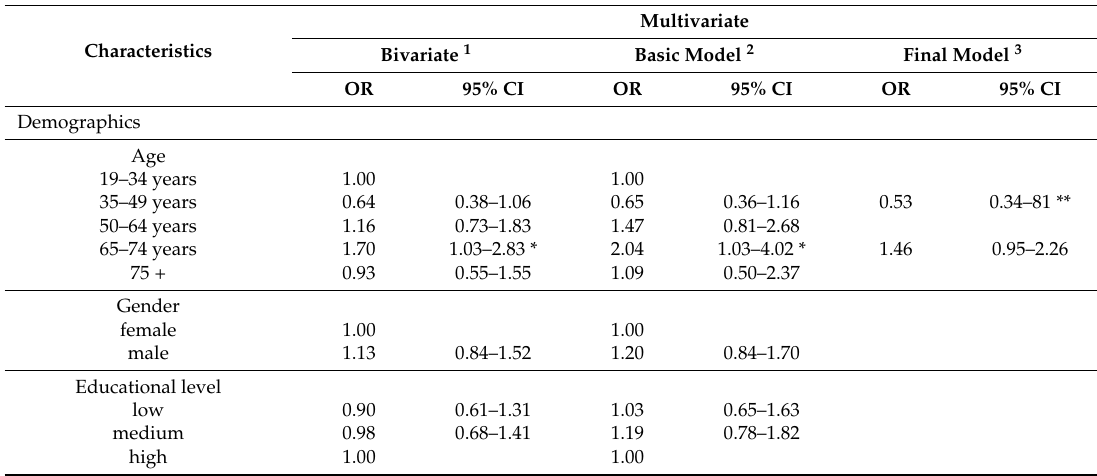
Table 2. Characteristics associated with non-disclosure of suicidal ideation in adults, and results of the backwards selection